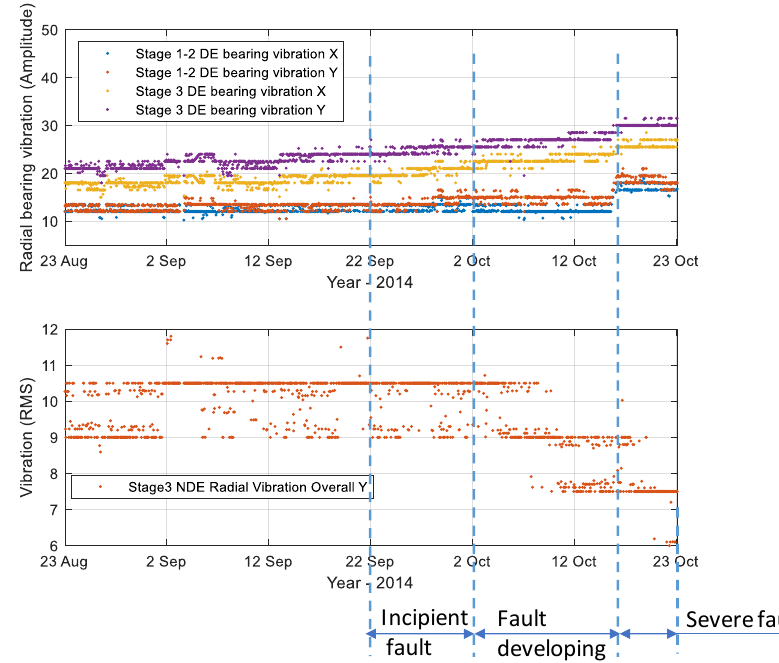
Figure 21. Fault relevant variables from the compressor’s condition monitoring system.